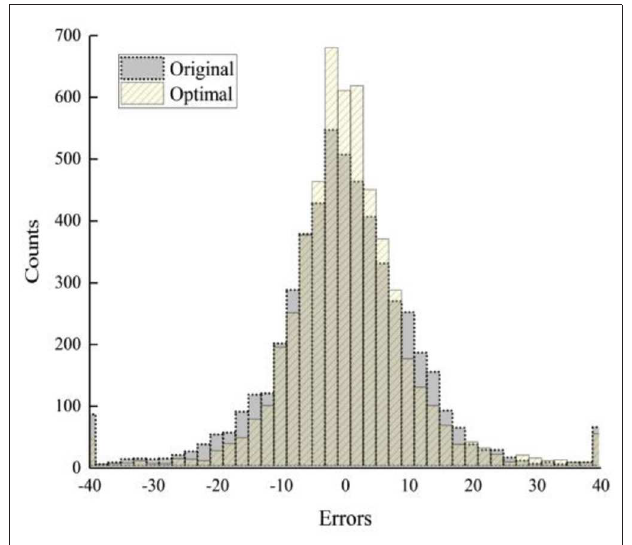
FIGURE 9 | Error distribution of the original and optimal network model.